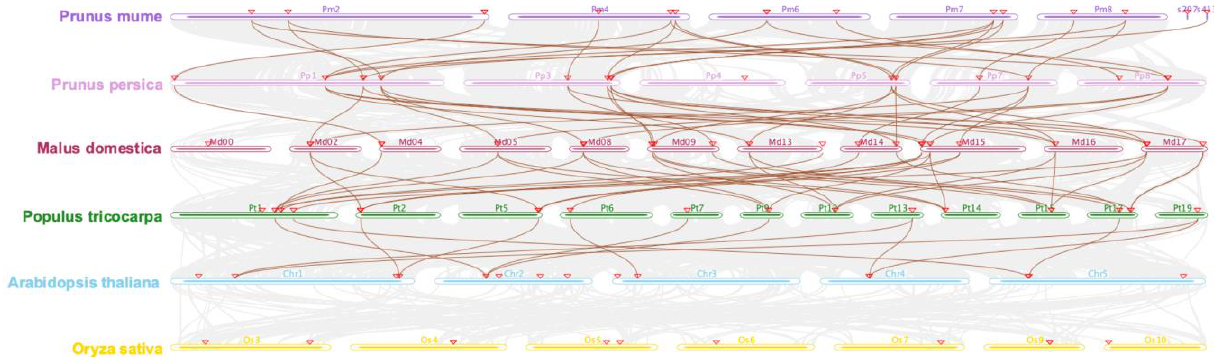
Figure 4. Synteny analysis of GASA genes between Arabidopsis thaliana , Malus domestica , Prunus mume , Prunus persica , Populus tricocarpa , and Oryza sativa. Red triangle boxes highlight the GASA family genes. The grey shade highlights syntenic regions between genomes, and the colored lines represent colinear GASA gene pairs. Table 3. The Ka/Ks ratios of paralogous gene pairs of PmGASA gene